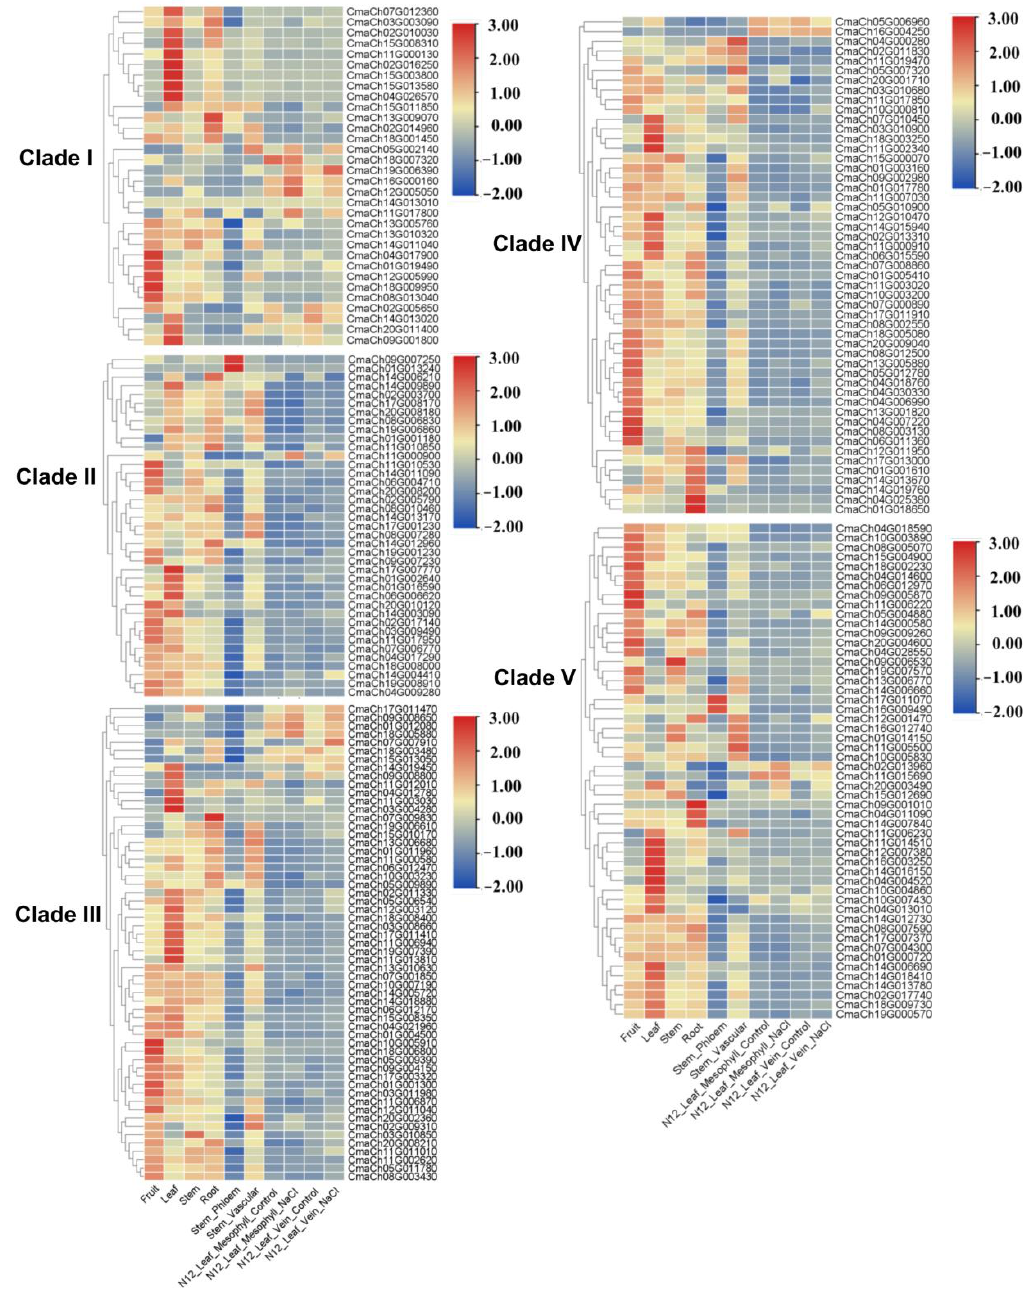
Figure 7. Heatmap of WD40 genes’ specific expression in leaf, root, fruit, stem, N12 leaf meso phyll, and vein after NaCl treatment. The data of expression in diverse organs downloaded from CuGenDB website can be seen in Table